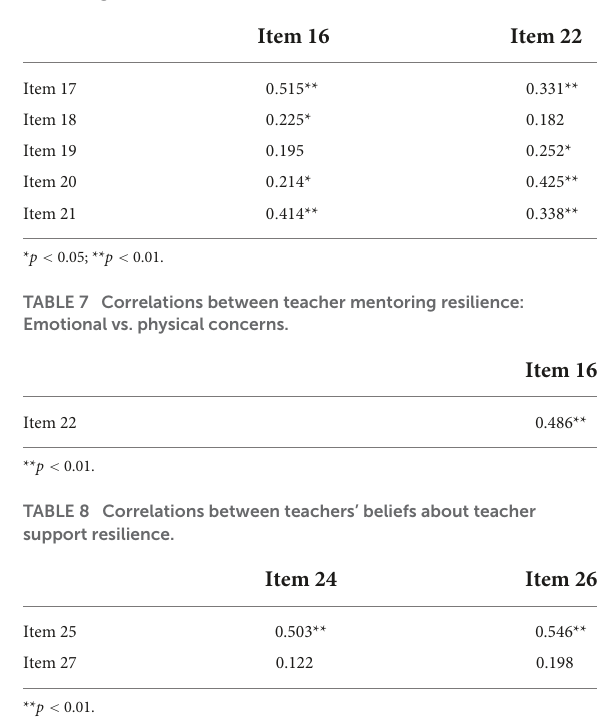
TABLE 6 Correlations between teachers’ beliefs about teacher mentoring resilience.